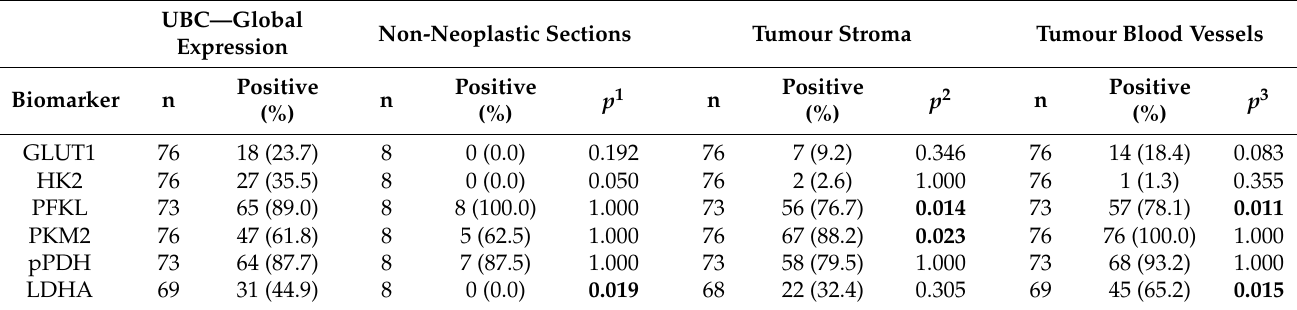
Table 1. Positive immunoexpression frequencies of metabolism-related biomarkers in urothelial bladder cancer samples (UBC—global expression), non-neoplastic sections, tumour stromal sections, and tumour blood